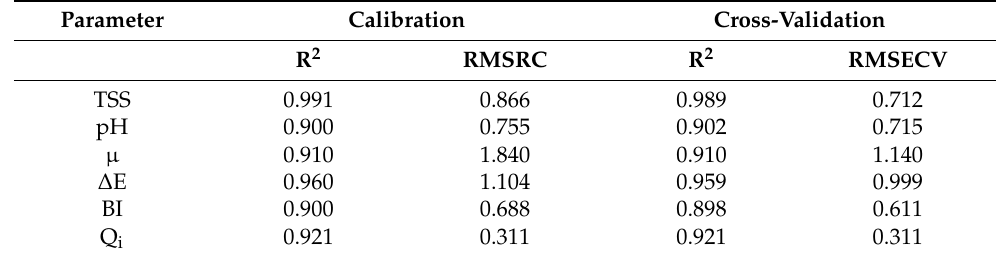
Table 5. ANN performance for TSS, pH, µ , ∆ E, BI, and Q I of flavored laban drinks for both calibration and cross-validation